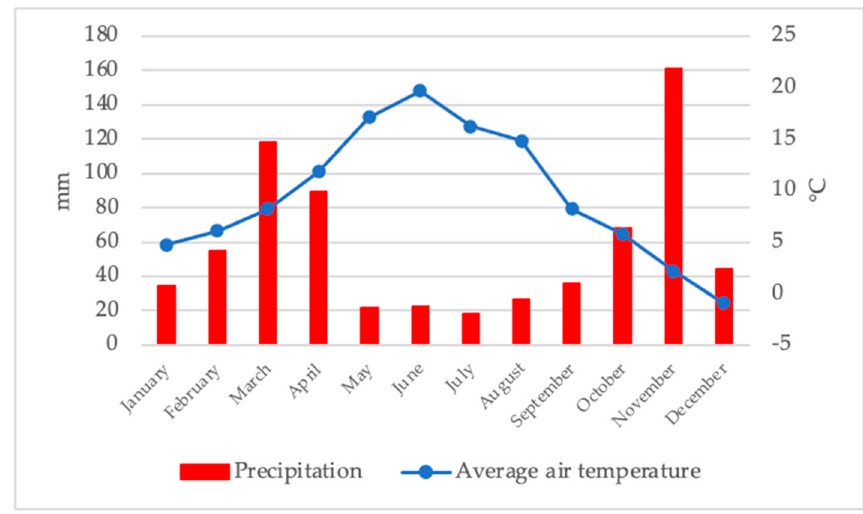
Figure 1. Climatic conditions (total rainfall and average air temperature) during 2017.